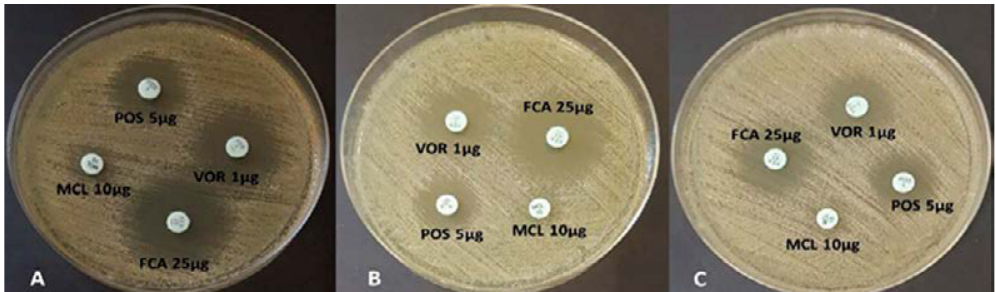
Fig. 2. Visualization of Candida albicans biofilms using fluorescence microscopy (X40 magnification). (A) 24-h, (B) 48-h, and (C) 72-h